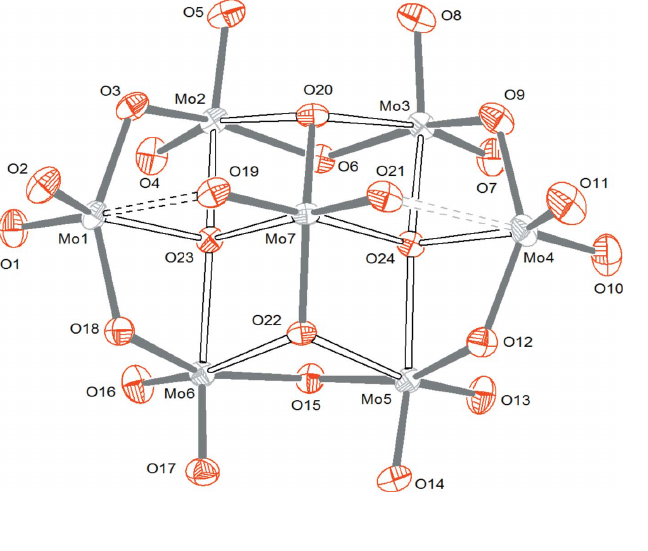
Figure 3 Detail of the structure of (I) showing the interconnections of the [Mo 7 O 24 ] 6 (cid:3) anion with its neighbours.